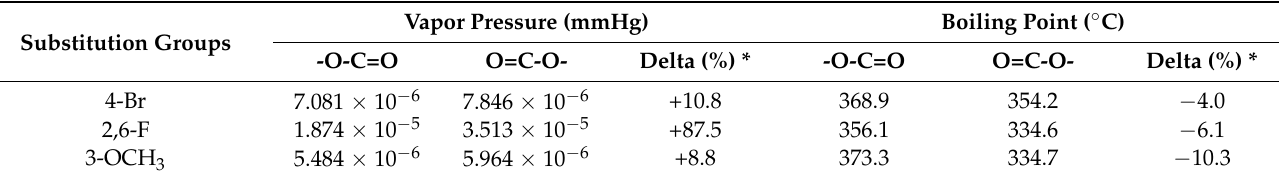
Table 3. Effect of inversion of ester groups on vapor pressure and boiling point.